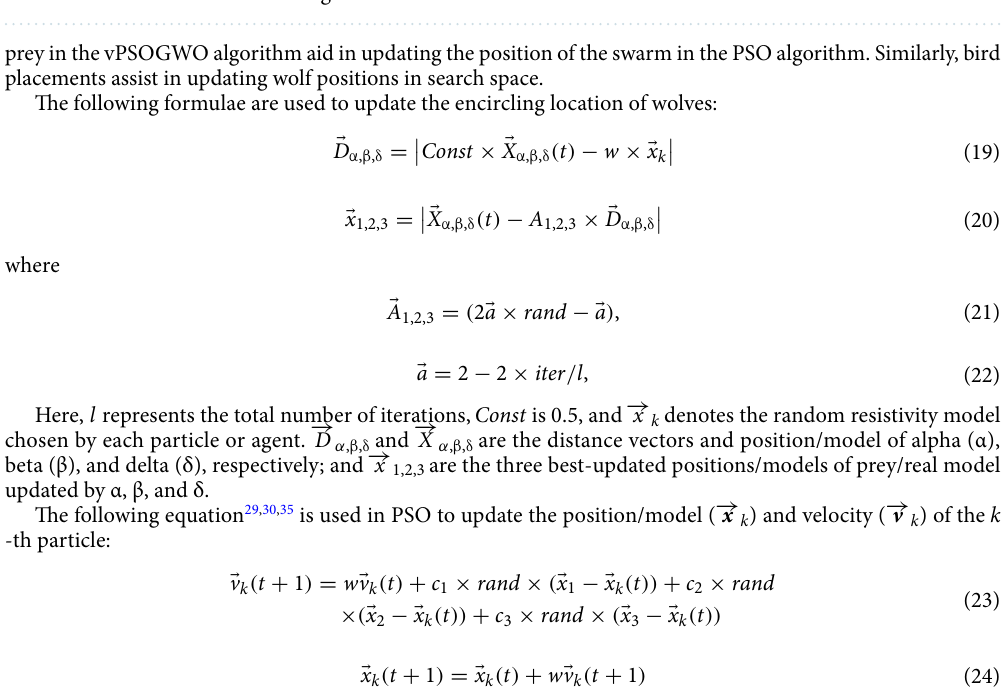
Figure 2. The procedures for individual and joint inversion of DC and MT data-based Grey Wolf Optimization are shown in the schematic flow